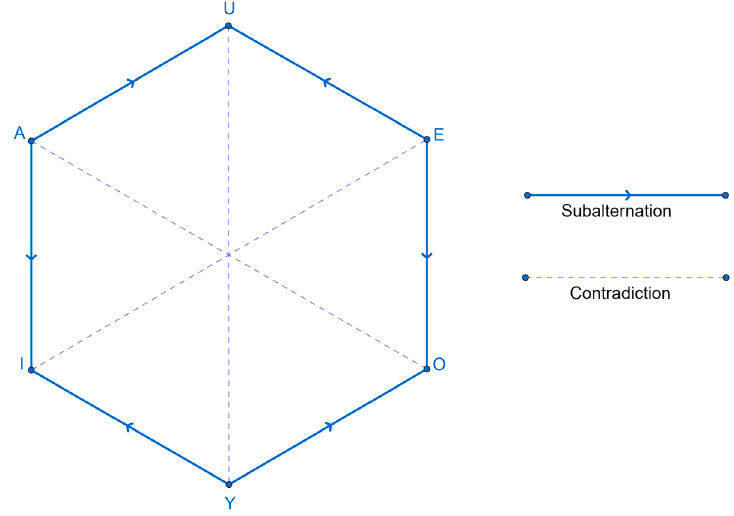
Figure 7. Blanch é ’s Hexagon, showing subalternation and contradiction among propositions located Figure 7. Blanché’s Hexagon, showing subalternation and contradiction among propositions lo- cated at vertices A, E, I, O, Y, and U. at vertices A, E, I, O, Y, and U. Table 2. The Interpretation of Blanch é ’s Y and U nodes. Node